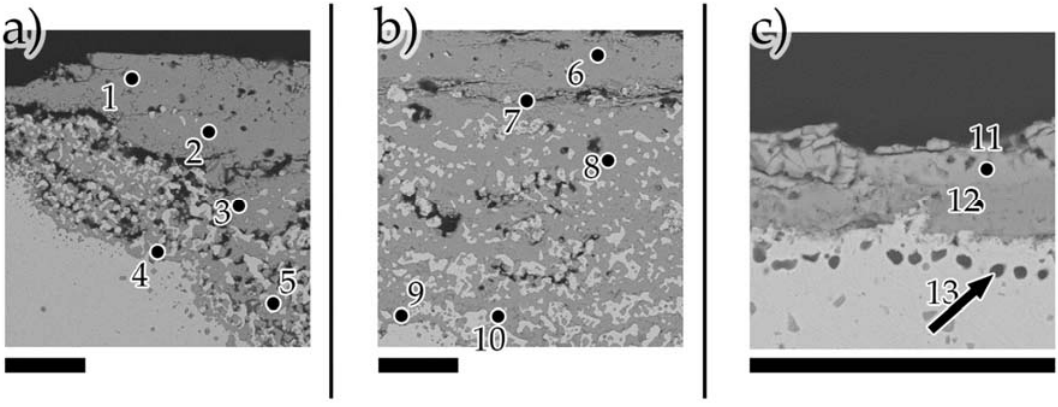
Figure 14. EDS point analysis locations in 1275 °C, ( a ) air, ( b ) oxyfuel and ( c ) lean oxyfuel atmospheres. Scale bar is 25 μ m. Table 5. EDS point analyses corresponding to Figure 14, in wt. %. No value indicated means the